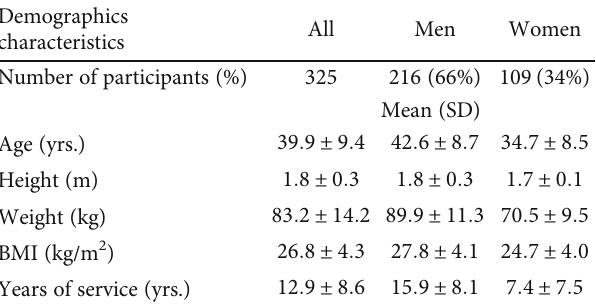
Table 1: Participants